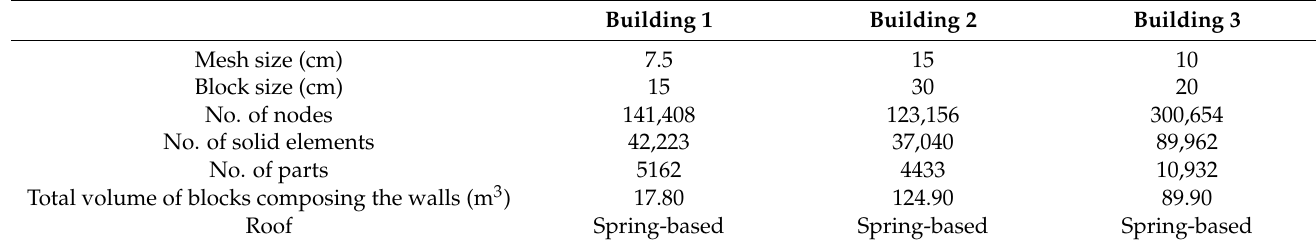
Table 3. Numerical modeling characteristics.